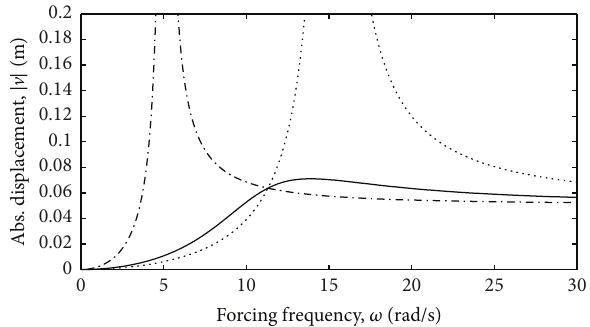
Figure 4: The theoretical frequency response curves of tip of beam with Ω min = 15850 rpmand 𝑧 = 0.05 m;for(dotted) 𝑘 = 0 and 𝑐 = 0 , for (dash-dot) 𝑘 = 𝐼 𝑜 𝜔 2 /2 and 𝑐 = 0 , and for (solid) 𝑘 = 𝐼 𝑜 𝜔 2 /2 and 𝜔 2 /4𝜔 𝑐 = 𝐼 𝑜 𝑔